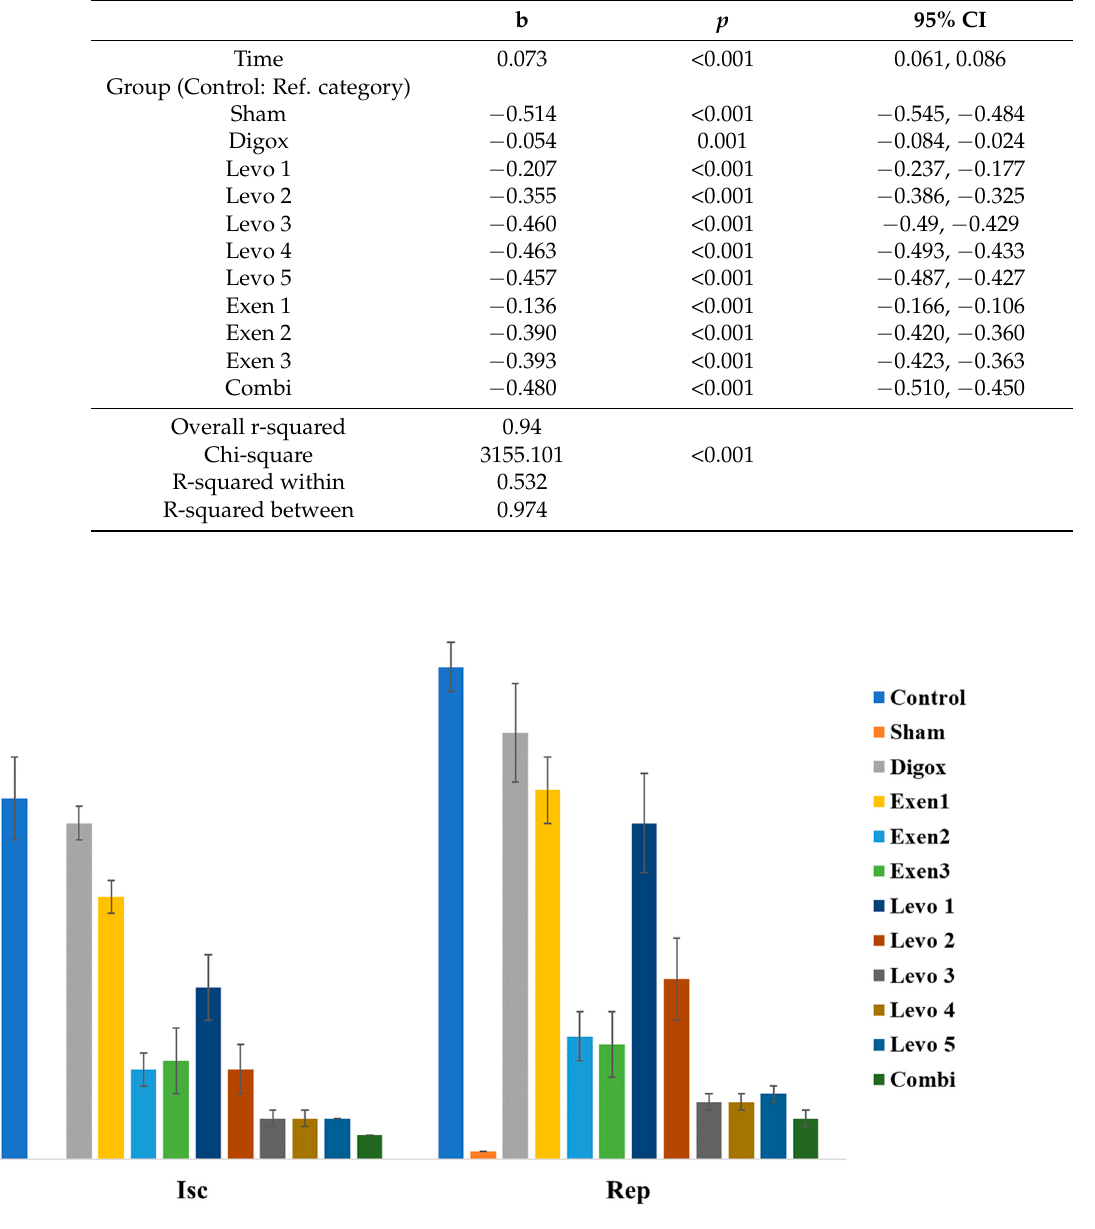
Figure 12. Changes in Troponin across groups over time.